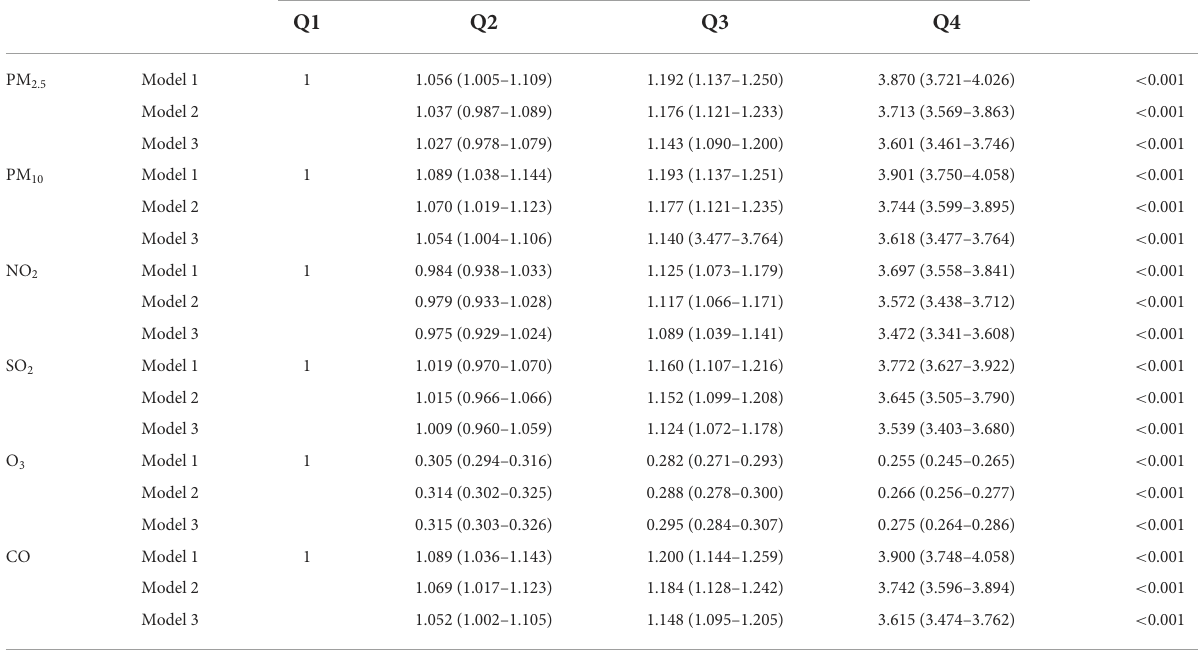
TABLE 2 HR and 95% CI for air pollution concentrations with the risk of incident CKD in the study. Air pollution concentrations